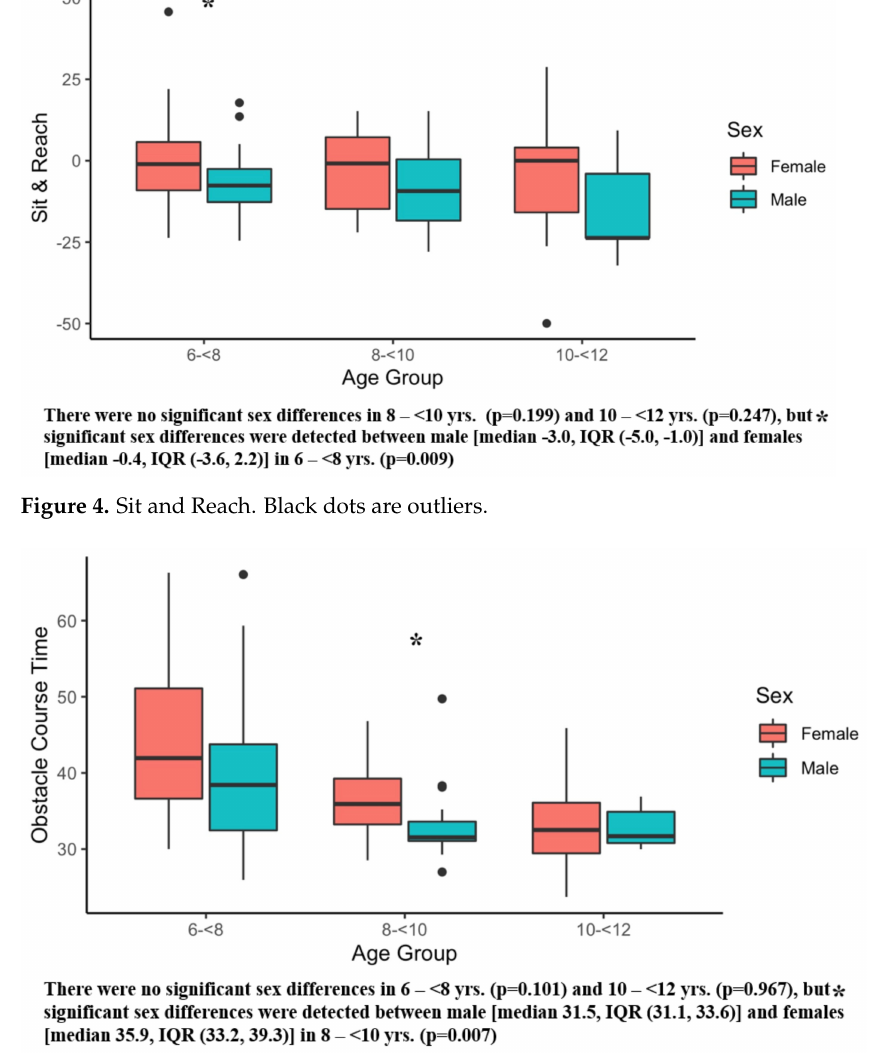
Figure 5. Obstacle Course Time. Black dots are